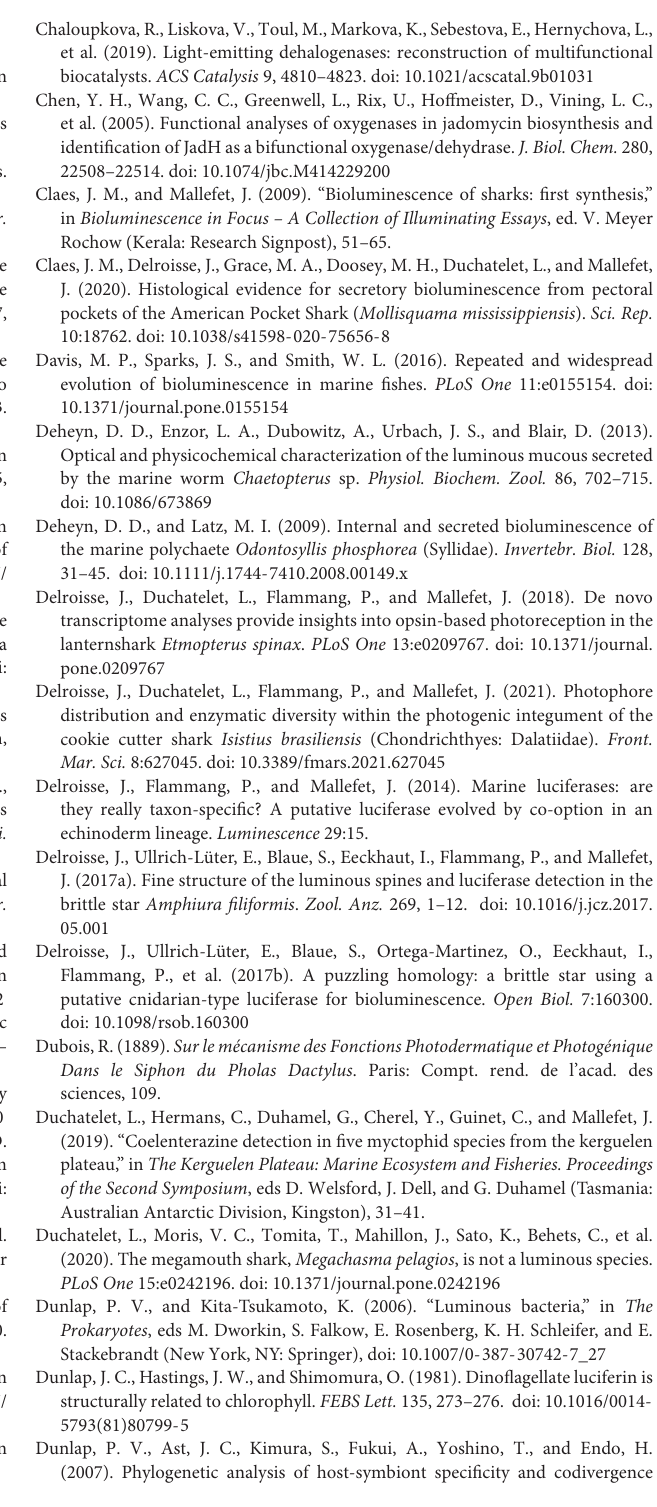
Supplementary Table 1 | List of known bioluminescent systems based on biochemical and molecular data (including the sequence references used for the CLANS analysis presented in Figure 2